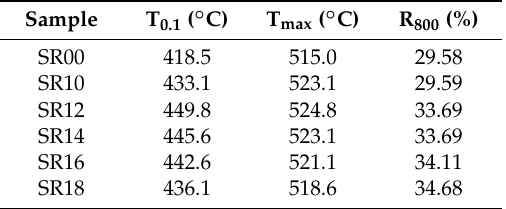
Figure 5. Thermogravimetric analysis (TGA) ( a ) and differential thermogravimetric analysis (DTGA) ( b ) curves of SR composites measured in air atmosphere. Table 3. Characteristic TGA temperature data of SR composites measured in air atmosphere.